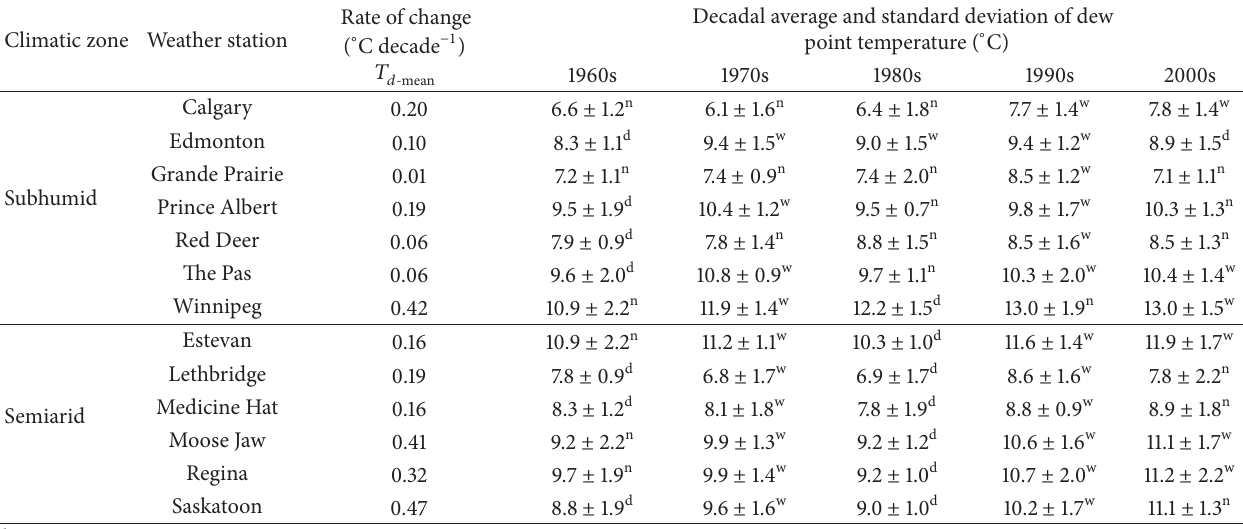
Table 2: Rate of change of the average decadal mean daily dew point temperature ( 𝑇 𝑑 dew point temperatures for climate stations representing selected ecodistricts in the Canadian Prairies for the 1960s to the 2000s.